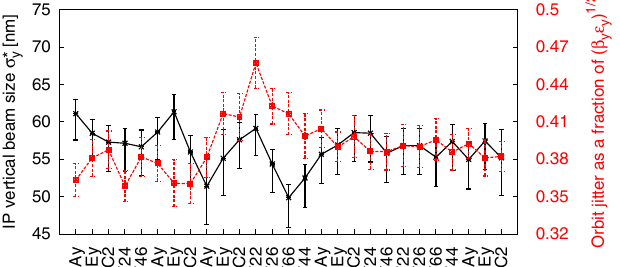
FIG. 8. IP vertical beam size (black) and the orbit jitter (red) versus the beam tuning in half β (cid:1) y , 10 β (cid:1) x optics. Points represent- ing the beam size correspond to the optimum knob setting and error bars account for the uncertainty of finding the optimum knob setting by fitting the knob scan data (as in Fig. 6) and for the systematic error of the Shintake monitor as described in Sec. II C.